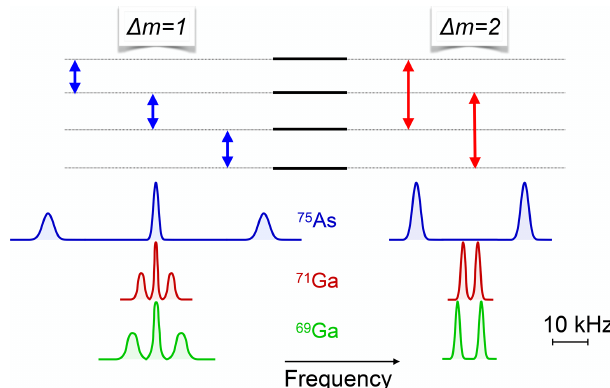
Figure 29. Quadrupole-split spectra of all three isotopes in the same EFG.